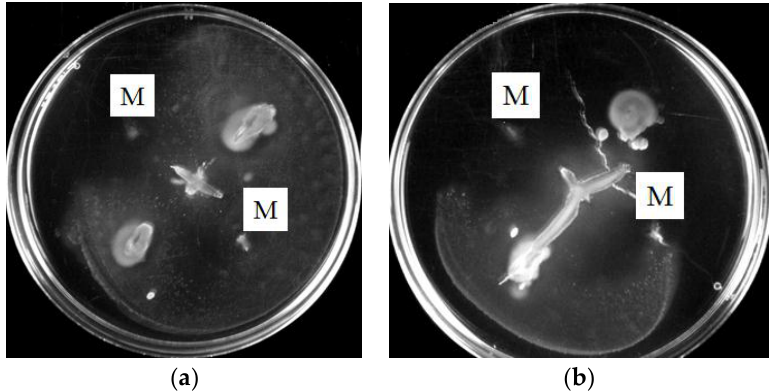
Figure 7. Interactions of mixed drinking water colonies with and without Methylobacterium , and of pure Methylobacterium colonies after 12 h of incubation: ( a ) Two mixed drinking water colonies and two pure colonies of Methylobacterium (indicated with “M”) and ( b ) two mixed drinking water colonies with 1% Methylobacterium inoculated, and two pure colonies of Methylobacterium (indicated with “M”).